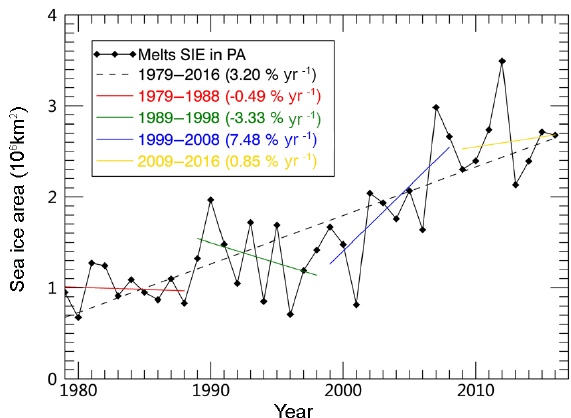
Figure 11. Time series for melting sea ice areas within PA.